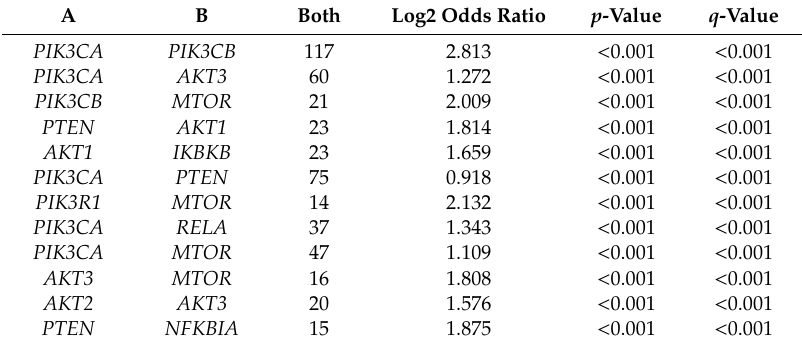
Table 2. Summary of the tendencies of PI3K / AKT / MTOR / NF κ B mutations to co-occur in OvCa (curated from http: //